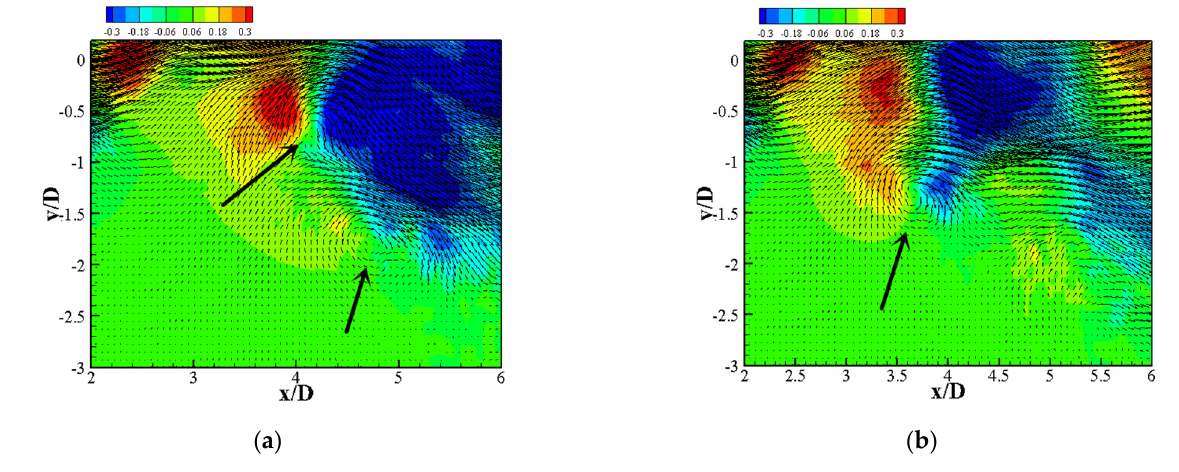
Figure 23. Radial velocity induced by the vortex rings, normalized by U j . ( a ) MFR = 0.83%, St D = 0.1, ( b ) MFR = 0.83%, St D = 0.15.